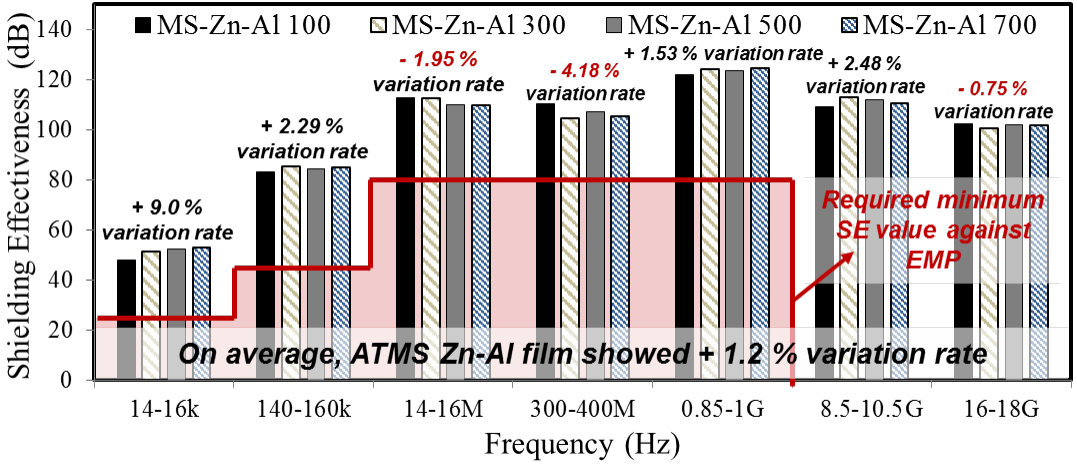
Figure 4. SE test result of ATMS coatings by Zn-Al in regards to thickness.